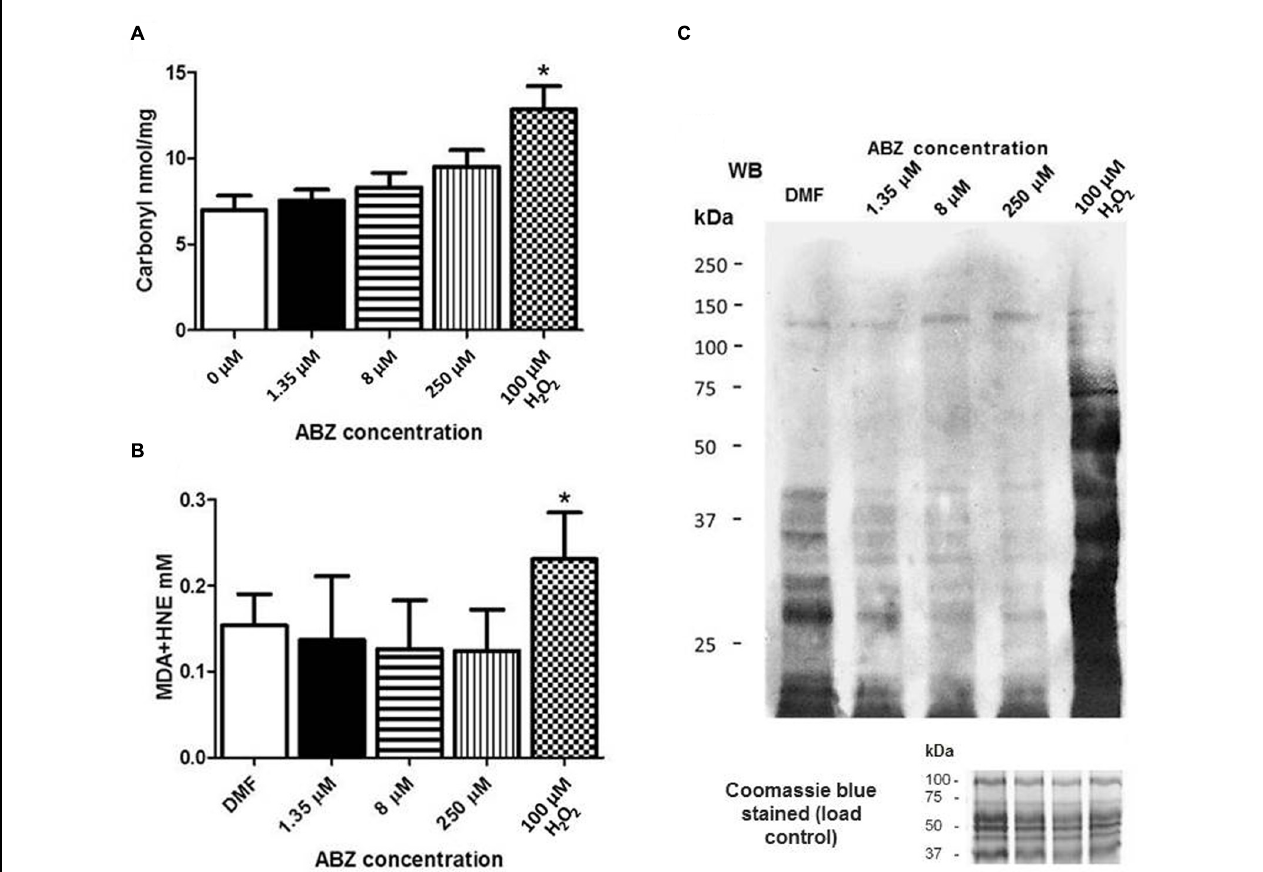
FIGURE 4 | Oxidative damage to proteins in G. duodenalis trophozoites exposed to ABZ. (A) Protein carbonylation in G. duodenalis ABZ-sensitive trophozoites (WB) exposed to ABZ. Parasites were exposed to vehicle (DMF white bars) or to different ABZ concentrations (1.35 μ M black bars; 8 μ M horizontal lined bars; 250 μ M vertical lined bars) for 16 h at 37 ◦ C. Control WB trophozoites were exposed to direct ROS damage with 100 μ M H 2 O 2 (white and black boxes). Proteins from each sample were obtained and were derivatized with DNPH for protein cabonylation determination. DNP-protein adducts were detected by absorbance at 450 nm. (B) Lipoperoxidation in trophozoites exposed to ABZ. After